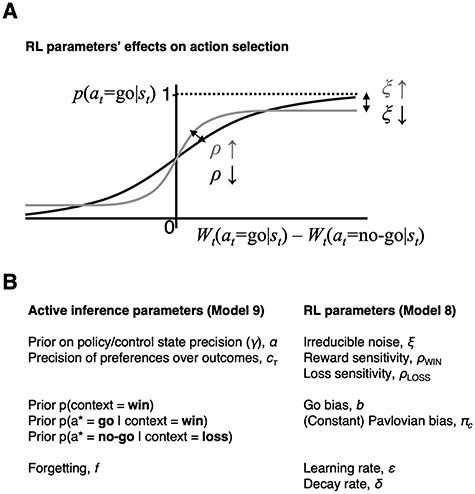
Action selection in RL, and how the RL parameters relate to those of AI. (A) This illustrates the effects of some RL parameters on action choices, but NB this is not how \documentclass[12pt]{minimal}
\usepackage{amsmath}
\usepackage{wasysym} 
\usepackage{amsfonts} 
\usepackage{amssymb} 
\usepackage{amsbsy}
\usepackage{upgreek}
\usepackage{mathrsfs}
\setlength{\oddsidemargin}{-69pt}
\begin{document}
}{}$\rho$\end{document} was implemented in the model itself. The point is that the effect of \documentclass[12pt]{minimal}
\usepackage{amsmath}
\usepackage{wasysym} 
\usepackage{amsfonts} 
\usepackage{amssymb} 
\usepackage{amsbsy}
\usepackage{upgreek}
\usepackage{mathrsfs}
\setlength{\oddsidemargin}{-69pt}
\begin{document}
}{}$\rho$\end{document} on decision making is mathematically identical to that of a softmax inverse temperature parameter, which scales the gradient of this plot, and hence how deterministically differences in action weights translate into actions. \documentclass[12pt]{minimal}
\usepackage{amsmath}
\usepackage{wasysym} 
\usepackage{amsfonts} 
\usepackage{amssymb} 
\usepackage{amsbsy}
\usepackage{upgreek}
\usepackage{mathrsfs}
\setlength{\oddsidemargin}{-69pt}
\begin{document}
}{}$\xi$\end{document} scales the distance of the asymptote from 1 or 0, that is, a consistent level of stochasticity no matter how great the difference between action weights. The role of \documentclass[12pt]{minimal}
\usepackage{amsmath}
\usepackage{wasysym} 
\usepackage{amsfonts} 
\usepackage{amssymb} 
\usepackage{amsbsy}
\usepackage{upgreek}
\usepackage{mathrsfs}
\setlength{\oddsidemargin}{-69pt}
\begin{document}
}{}$\gamma$\end{document} in the AI model is most similar to that of \documentclass[12pt]{minimal}
\usepackage{amsmath}
\usepackage{wasysym} 
\usepackage{amsfonts} 
\usepackage{amssymb} 
\usepackage{amsbsy}
\usepackage{upgreek}
\usepackage{mathrsfs}
\setlength{\oddsidemargin}{-69pt}
\begin{document}
}{}$\rho$\end{document} here, except that it is updated on every trial, so as confidence increases, actions become more deterministic. (B) The parameters are listed for AI and the most complex RL model. The parameters are separated into three broad groups across both models: those pertaining to stochasticity, biases, and the speed of belief changes (respectively).